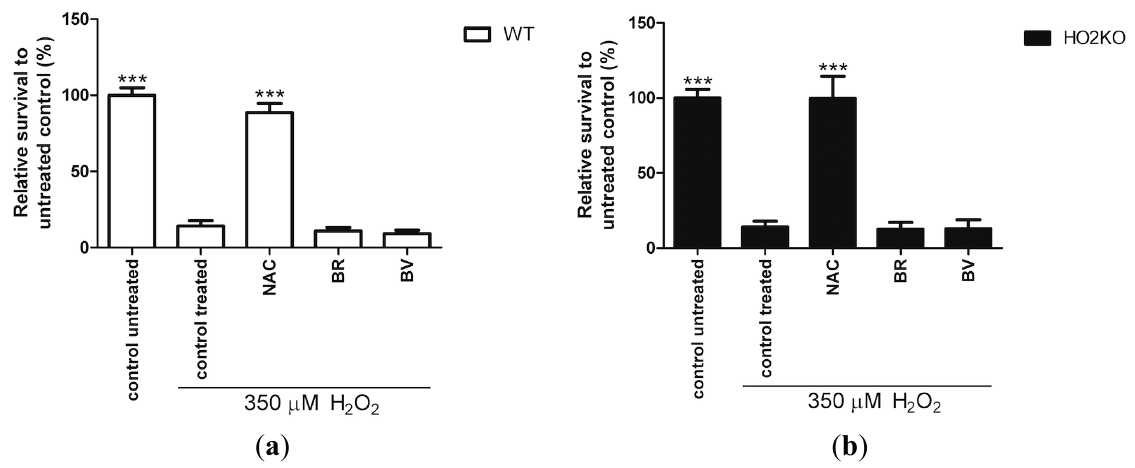
Figure 6. Survival of WT and HO-2 KO ASC against H 2 O 2 -induced cell death after treatment with anti-oxidants. ( a ) WT ASC and ( b ) HO-2 KO ASC survival after 24 h pre-treatment with anti-oxidant NAC or HO-effector molecules BR and BV, and 24 h co-treatment together with 350 µM H 2 O 2 following an Alamar blue assay and fluorimetric quantification, related to untreated control. * is significant different from treated